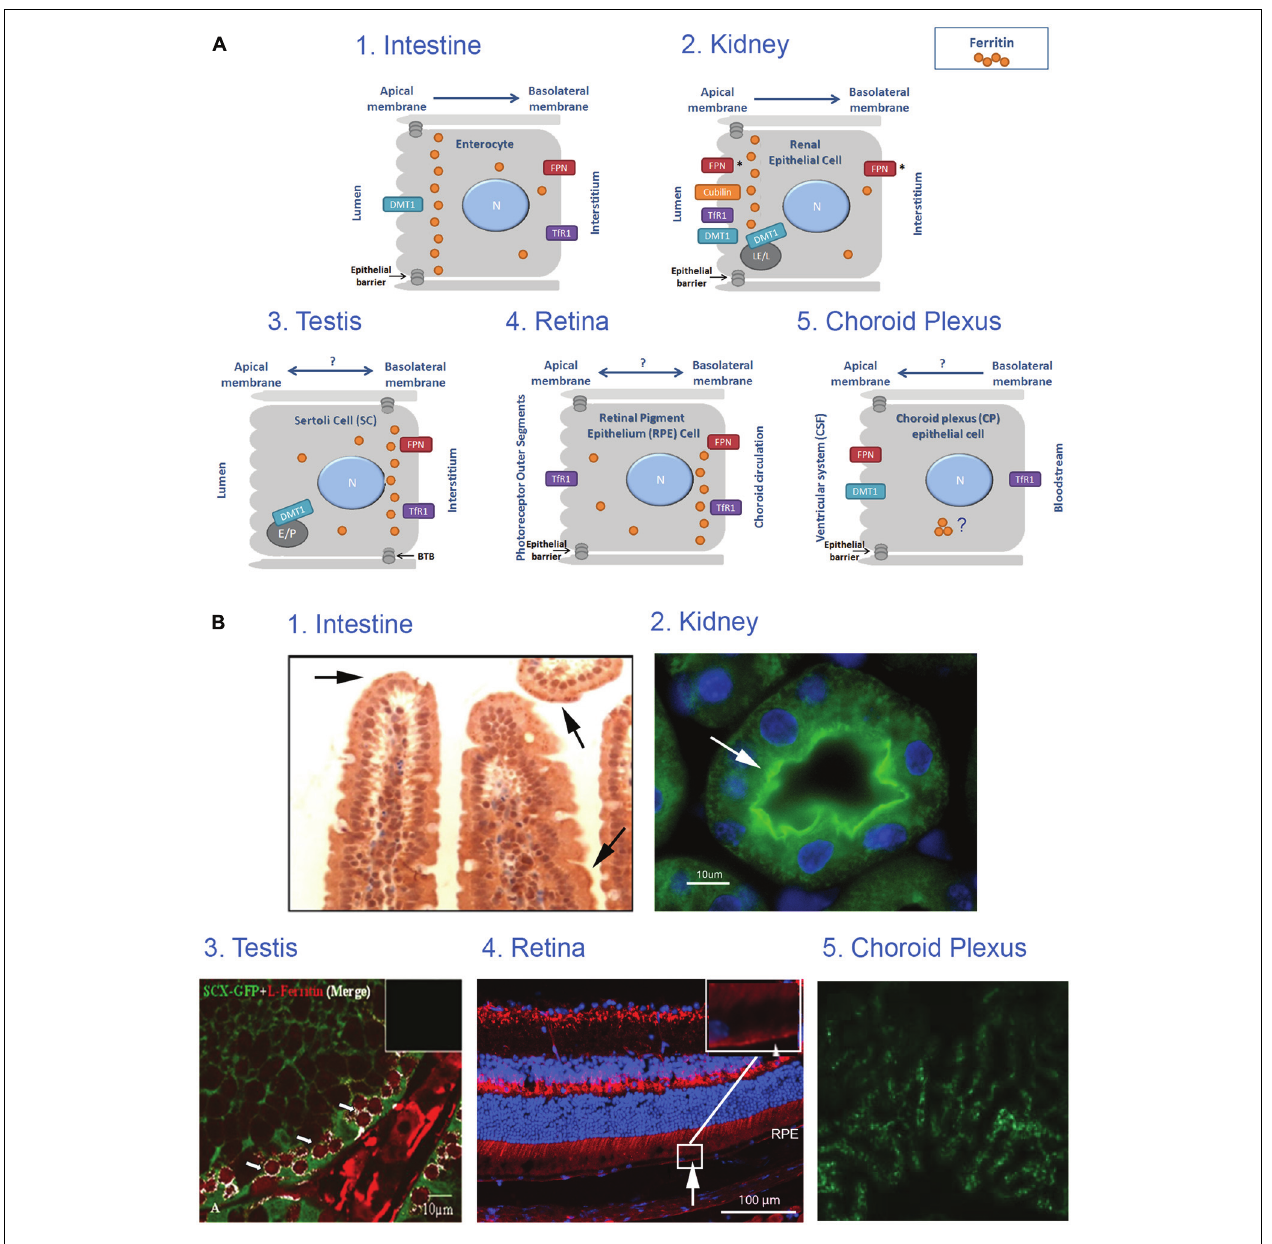
distribution in renal proximal tubule cells where ferritin was co-localized with villin (arrow) and was enriched near the apical pole of the PCT-cells. (3) Testis sections stained with rabbit anti-ferritin L antibody (red) and polyclonal GFP antibody (green), (from Leichtmann-Bardoogo etal., 2012), and reveals that ferritin is enriched in the SC cytosol close to the basolateral pole (white), especially around the early primary spermatocyte. (4) Retinal samples stained with rabbit anti-ferritin L antibody (red). Nuclei were stained with DAPI (blue; unpublished data, Joshua Dunaief, personal communication). This image reveals that ferritin is distributed in a polarized manner and was localized to the basal RPE (arrow) in a WT C57BL6/J retina. (5) Choroid plexus samples stained with anti-ferritin antibody (green), (from Rouault etal., 2009) shows expression of ferritin in 24-months old mouse-choroid plexus, but subcellular location cannot be determined. Permissions have been obtained for use of copyrighted material from all these